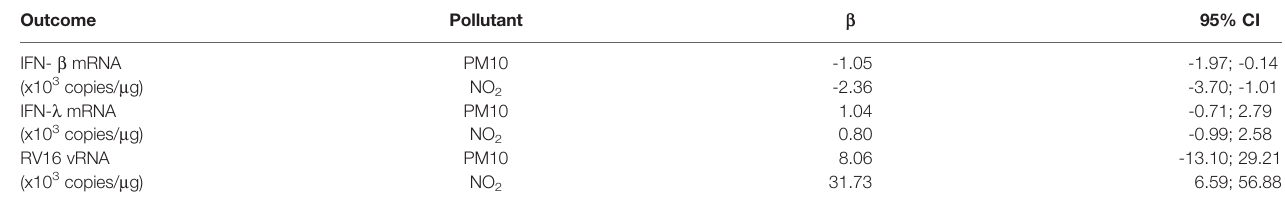
TABLE 2 | b coef fi cients and relative 95% Con fi dence Interval (CI) of the multivariable models.